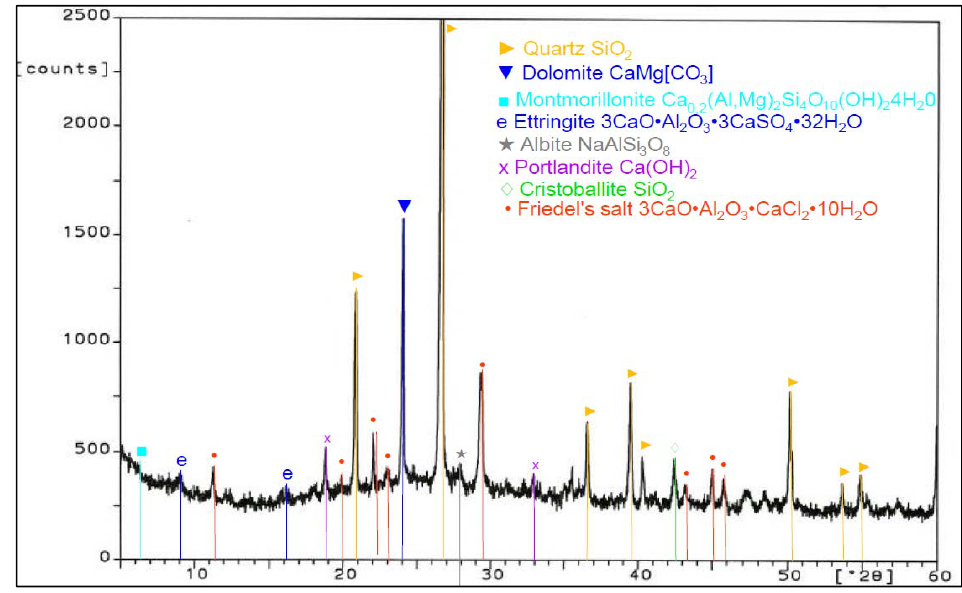
Figure 24. XRD pattern of the ZII mortar (CEM I + 30% FBC) stored in 1% HCl for 730 days.